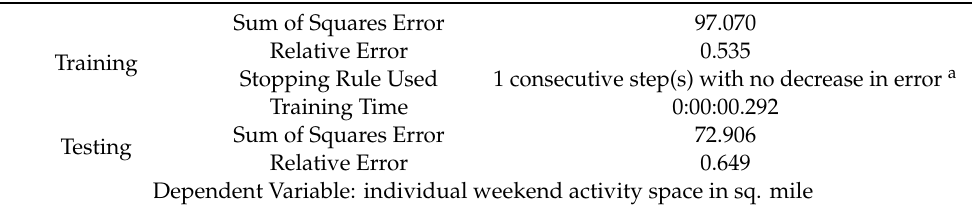
Table 14. Model Summary.